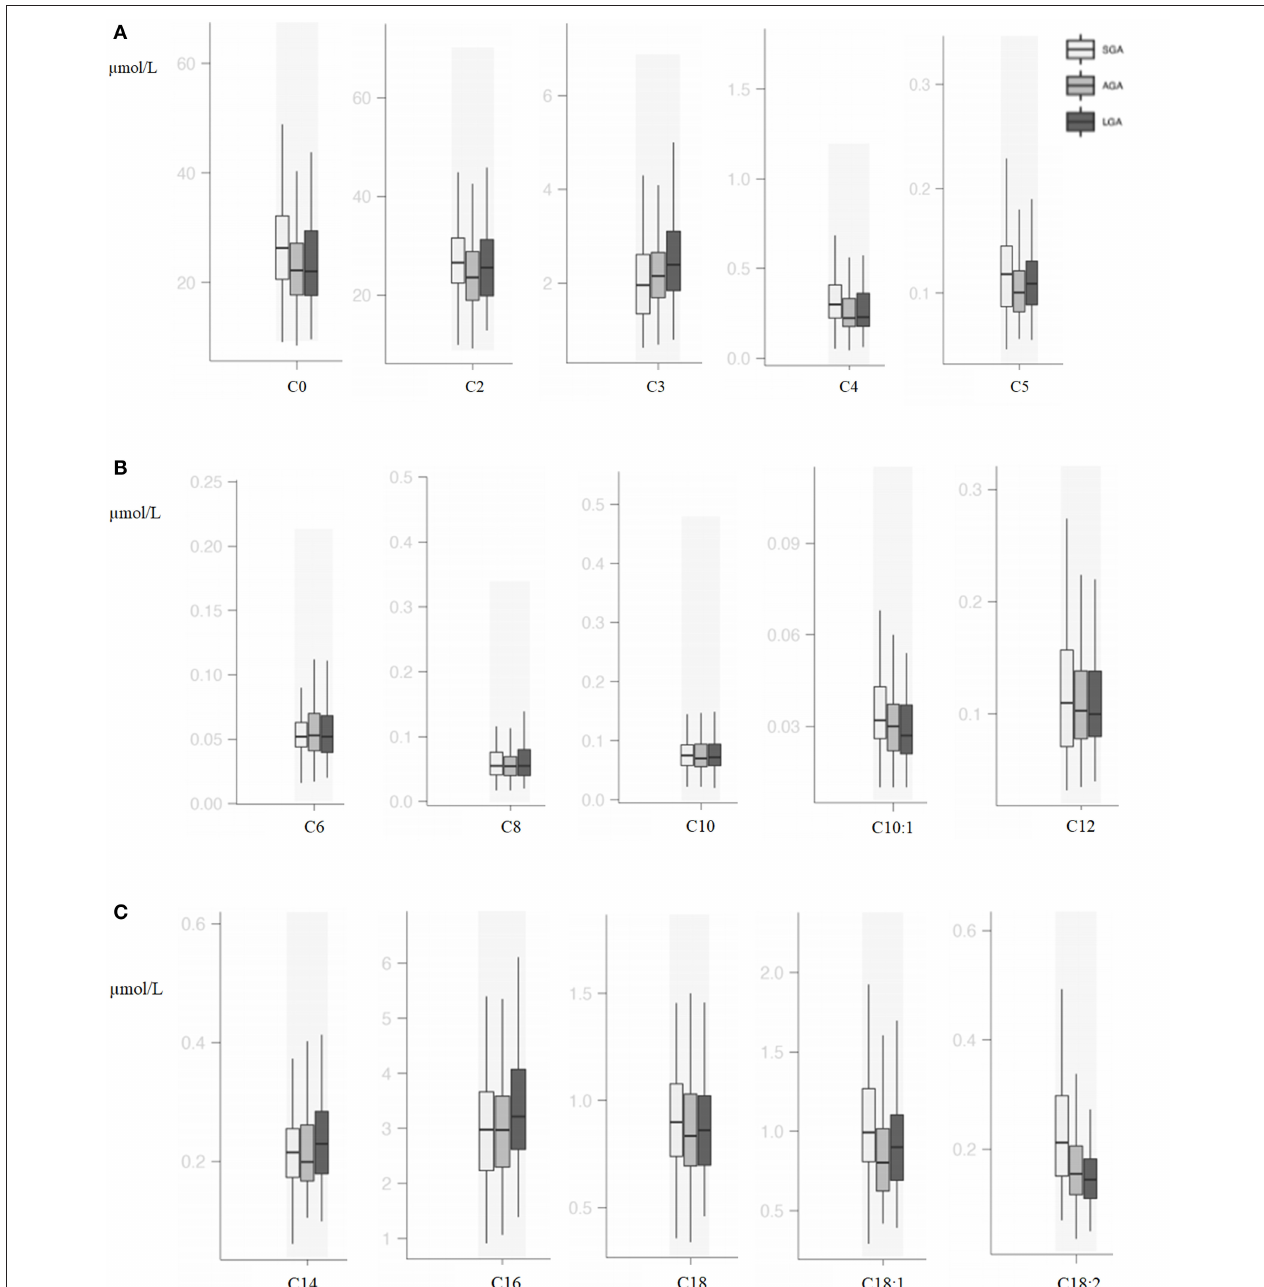
FIGURE 2 | (A) Box and whisker plots of free carnitine and short-chain acylcarnitines among groups. (B) Box and whisker plots of medium-chain acylcarnitines among groups. (C) Box and whisker plots of long-chain acylcarnitines among groups.